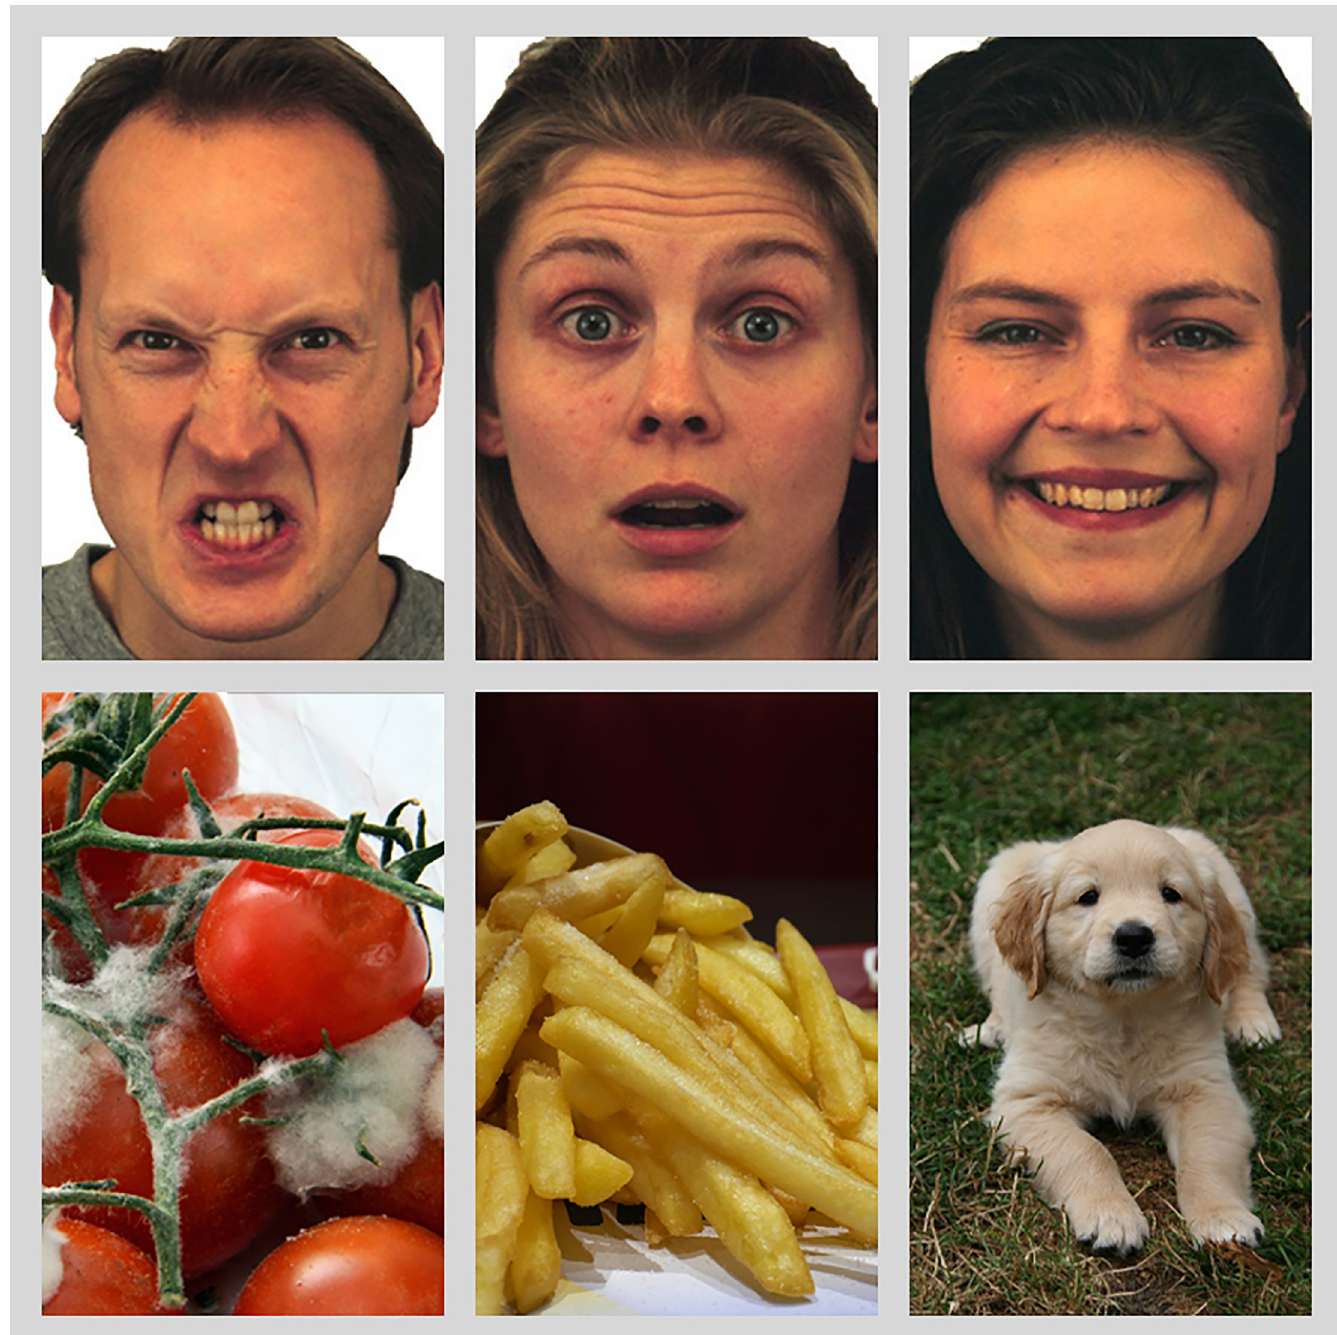
Fig 1. Negative, ambiguous, and positive images. Examples of clearly valenced and ambiguous images are shown. The selected faces come from the KDEF stimulus set and feature AF06HAS, AM10ANS, and AF30SUS. The additional scenes represent the types of IAPS stimuli used in our current study.